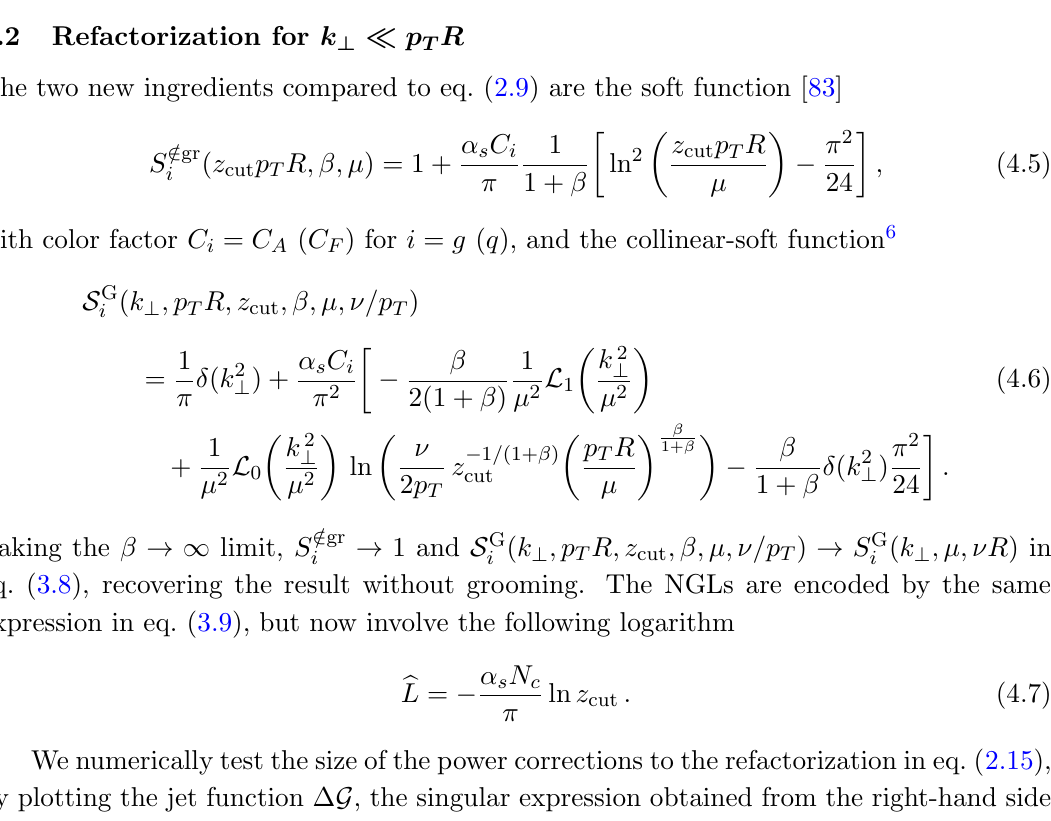
Figure 5 . Testing the refactorization (blue dashed) of the jet function (cid:1) for the angle between the groomed axis (with z cut = 0 : 1, (cid:12) = 0) and WTA axis in eq. (2.9) at ( (cid:11) s ). The nonsingular (green dotted) is the di(cid:11)erence. The left (right) panel corresponds to O quark (gluon)